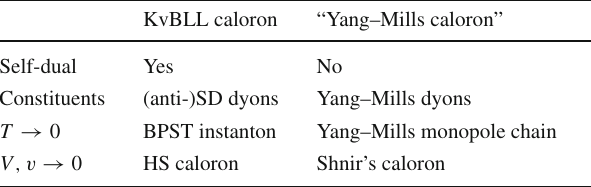
Table 1 Properties of the KvBLL caloron and the Yang–Mills caloron for comparison. The Shnir’s caloron found in [37] contains the HS caloron in a minimal topological charge sector. Moreover, in the limit V → 0,themassiveYang–Millstheoryreducestotheordinarymassless Yang–Mills theory, since the scalar field φ